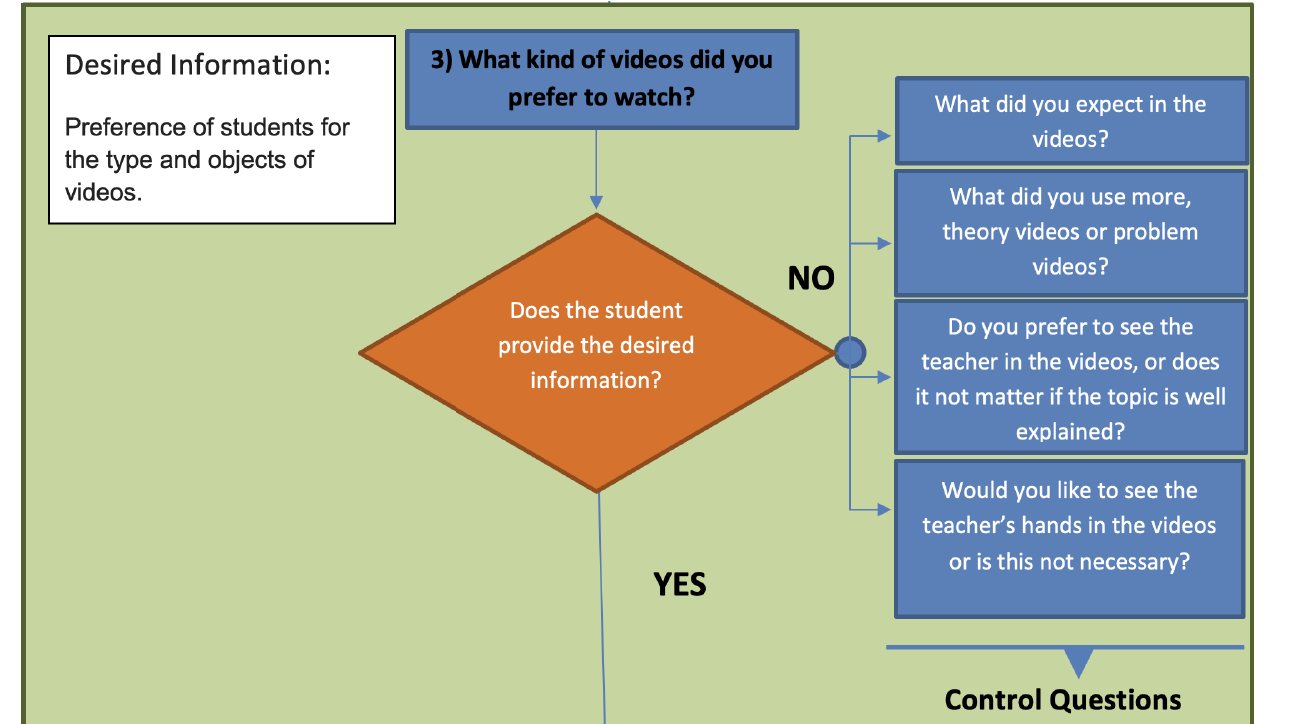
Figure A4. Structure of the interview (IV).